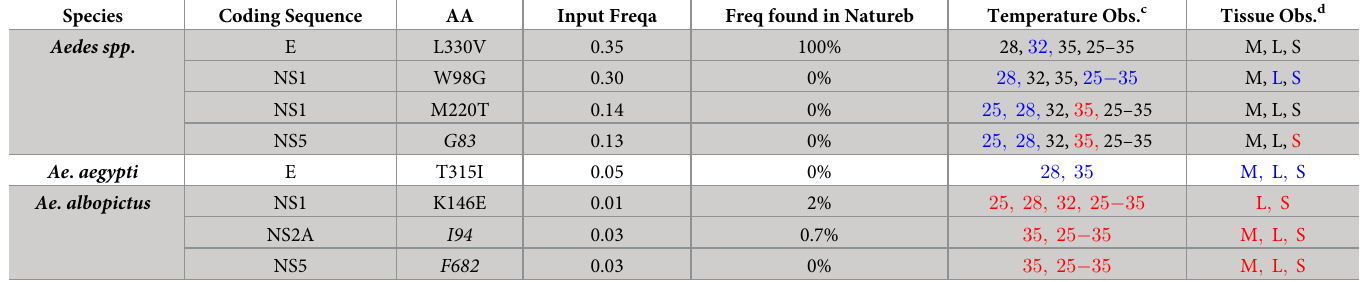
Table 1. Multiple ZIKV variants found in across biological samples and EITs go to consensus. a Variant frequency found in the stock input ZIKV population. b The percent sequence identity observed in nature when aligned to 150 complete ZIKV genomes. c Extrinsic incubation EITs at which each intrahost SNV (iSNV) was observed, d and tissues that each iSNV was observed. Black = both species, Blue = Ae. aegypti only, Red = Ae. albopictus only. (M) midguts; (L) legs; (S) saliva. Species Coding Sequence Temperature Obs. c Tissue Obs. d Aedes spp